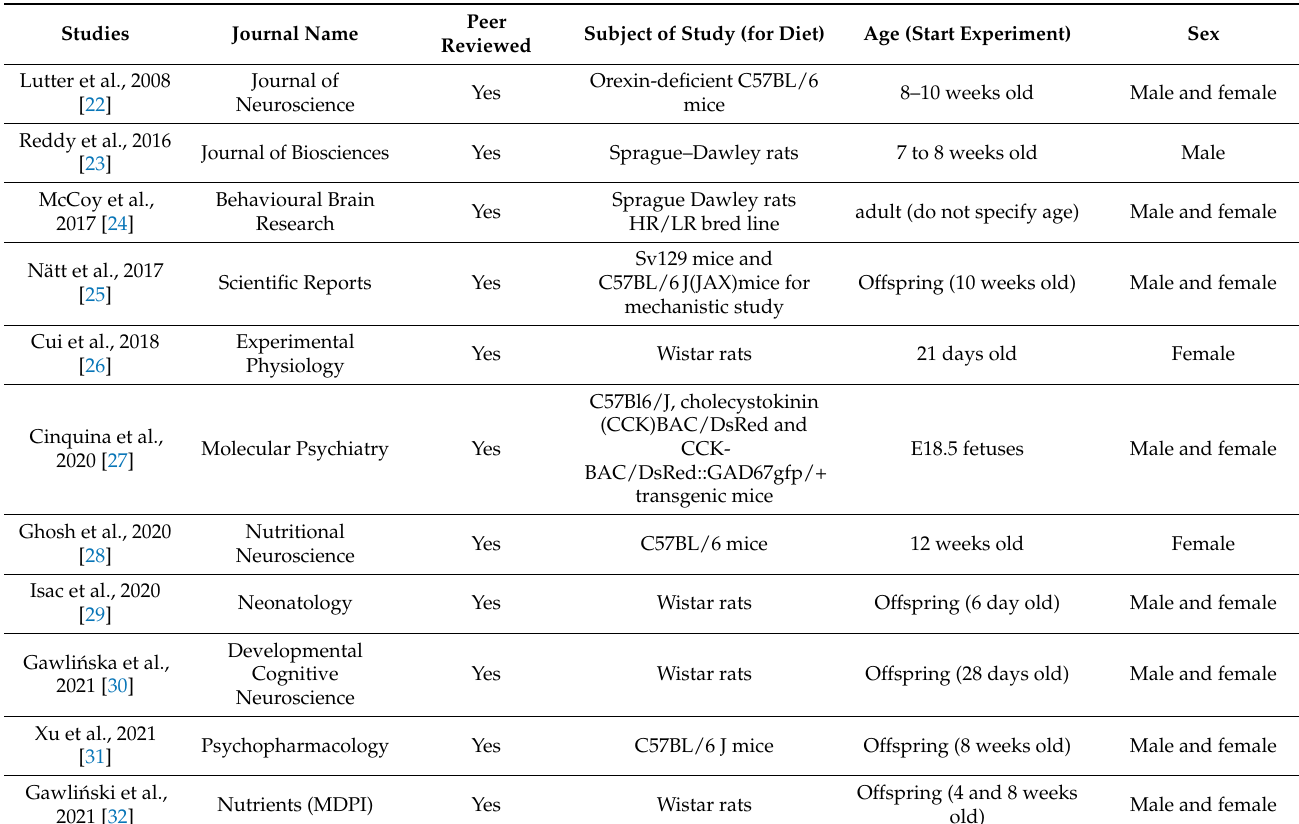
Table 1. General characteristics of included